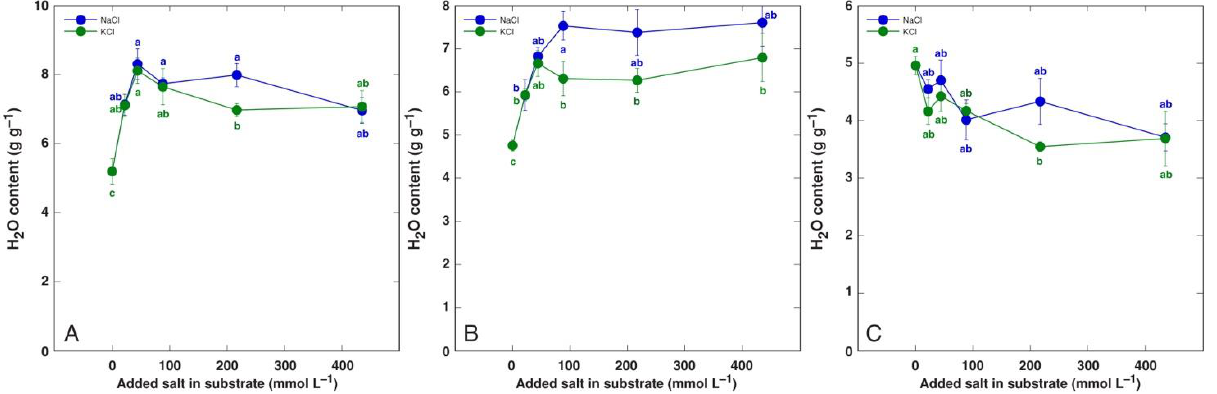
Figure 6. Effect of increasing salinity on leaf water content in three ecologically distinct Plantago species. Different letters of respective color indicate statistically significant differences ( p < 0.05) for the same species. Data were taken from Al Hassan et al., 2016 [185] and recalculated.